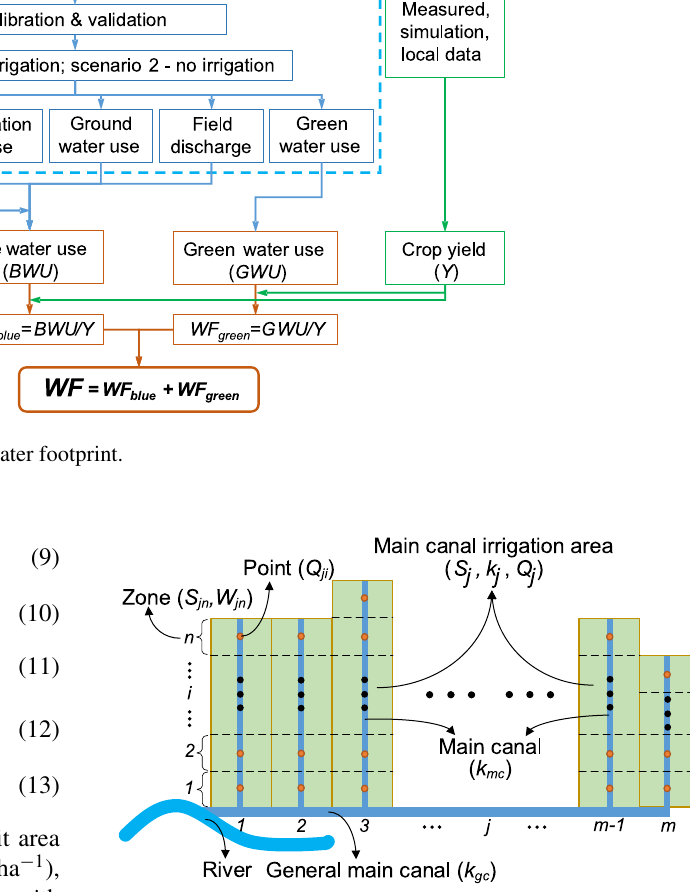
Figure 4. Model for the calculation of water loss in the canal sys-